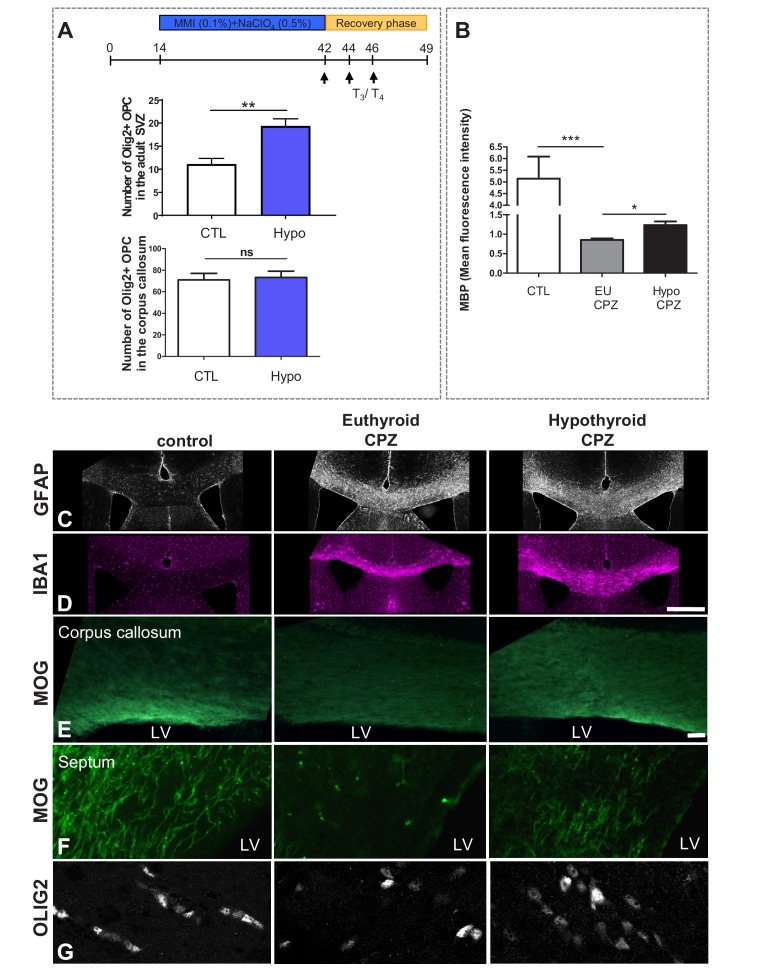
A T3-free window during CPZ demyelination increases remyelination.(A) Quantification of OLIG2+ oligodendrocyte progenitors in the SVZ and in the corpus callosum following four weeks of hypothyroidism (without cuprizone). (B) Quantification of MBP mean fluorescence intensity in the corpus callosum in control, EuCPZ and HypoCPZ mice (C and D) Hypothyroidism does not affect astrocyte (GFAP, grey) or microglial (IBA1, pink) responses. Scale bar: 500 µm. (E and F) Extent of remyelination was evaluated by MOG immunostaining in the corpus callosum (E) and in the septum (F) one week after the end of CPZ treatment. The mild remyelination observed in euthyroid mice contrasts with the intense remyelination of hypothyroid mice both in corpus callosum (E) and in the septum (F). Scale bar: 100 µm. (G) Extent of remyelination was evaluated by OLIG2 immunostaining in the corpus callosum one week after the end of CPZ diet. Scale bar: 30 µm.